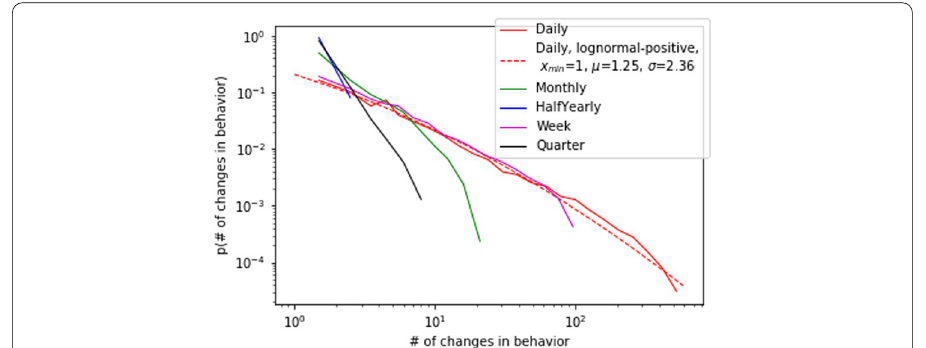
Fig. 13 Probability distribution of number of changes in behavior of accounts with certain probability for being benign at different T g s